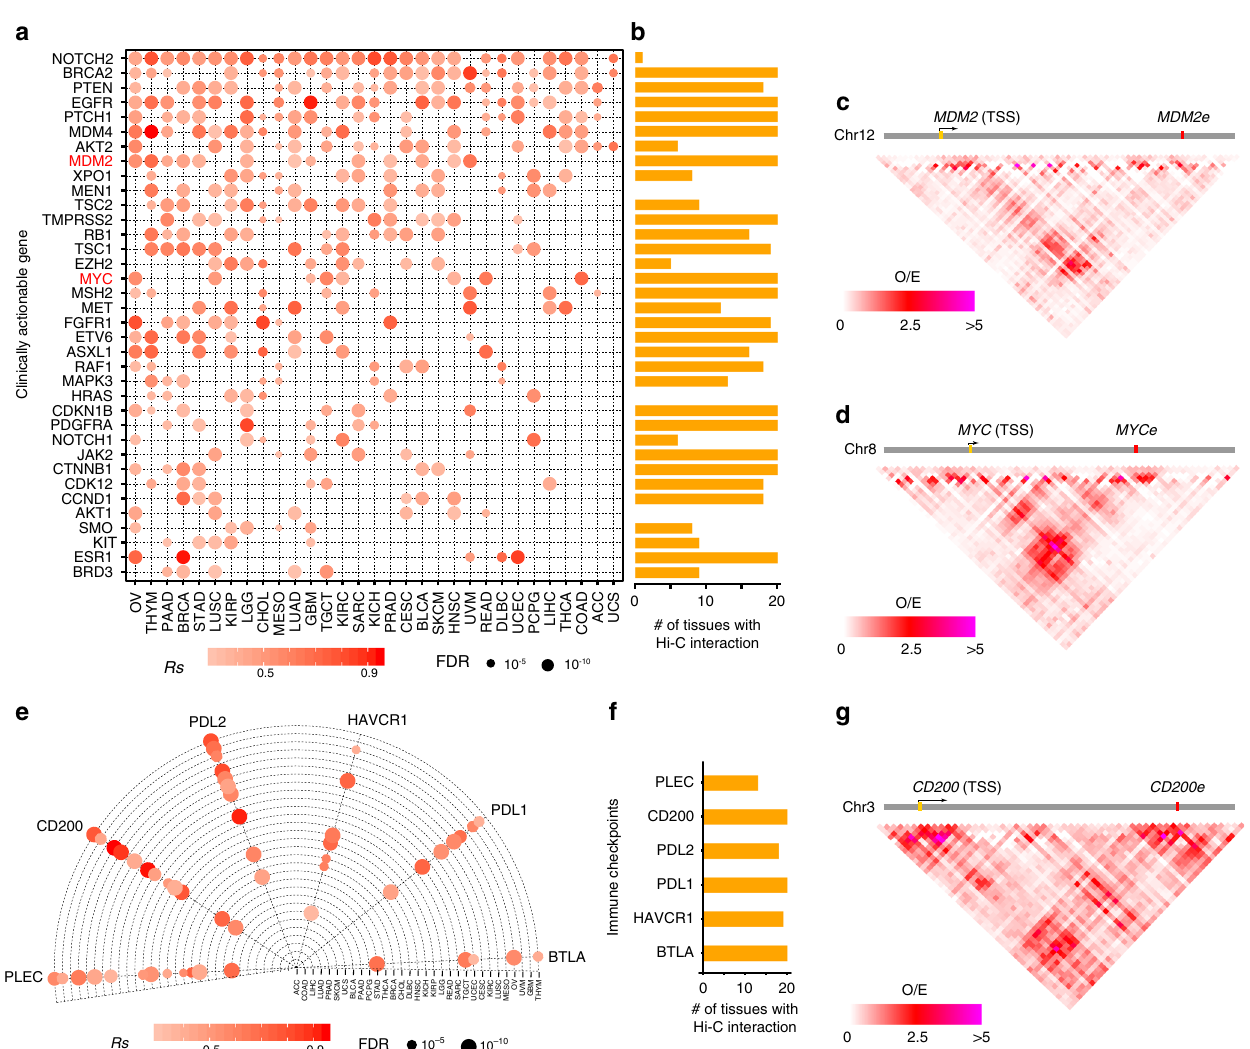
Fig. 4 Putatively regulatory effects of eRNAs on clinically actionable genes and immune checkpoints. a Correlation between eRNAs and clinically actionable genes in human cancers. Red dots denote signi fi cantly correlation. X -axis is cancer type and y -axis is symbol of gene. b Number of tissues with Hi-C interactions between clinically actionable genes and their eRNAs. c Hi-C interaction between MDM2 and MDM2e in blade. d Hi-C interaction between MYC and MYCe in lung. e Correlation between eRNA and cancer immune checkpoints in human cancers. f Number of tissues with remarkable Hi-C interaction between cancer immune checkpoints and their eRNA. g Hi-C interaction between CD200 and CD200e in ovary. Scale bars denote spearman correlation ( Rs ) in ( a ) and ( e ), and Hi-C O/E value in ( b ), ( c ), and ( g ),